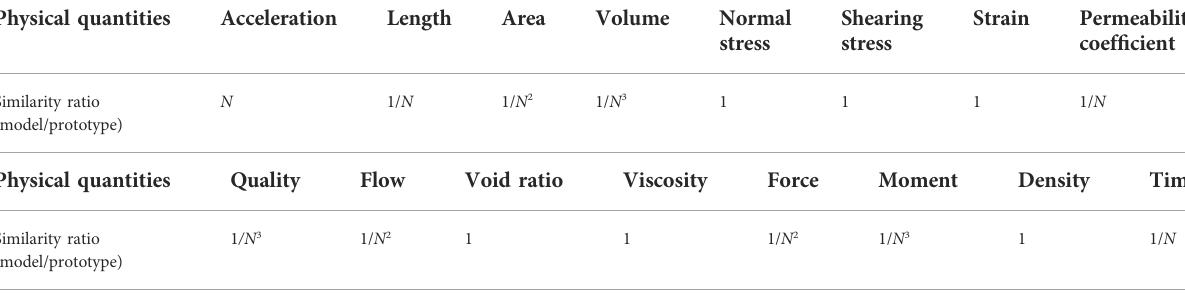
TABLE 1 The similarity criteria of common physical quantities in centrifugal model